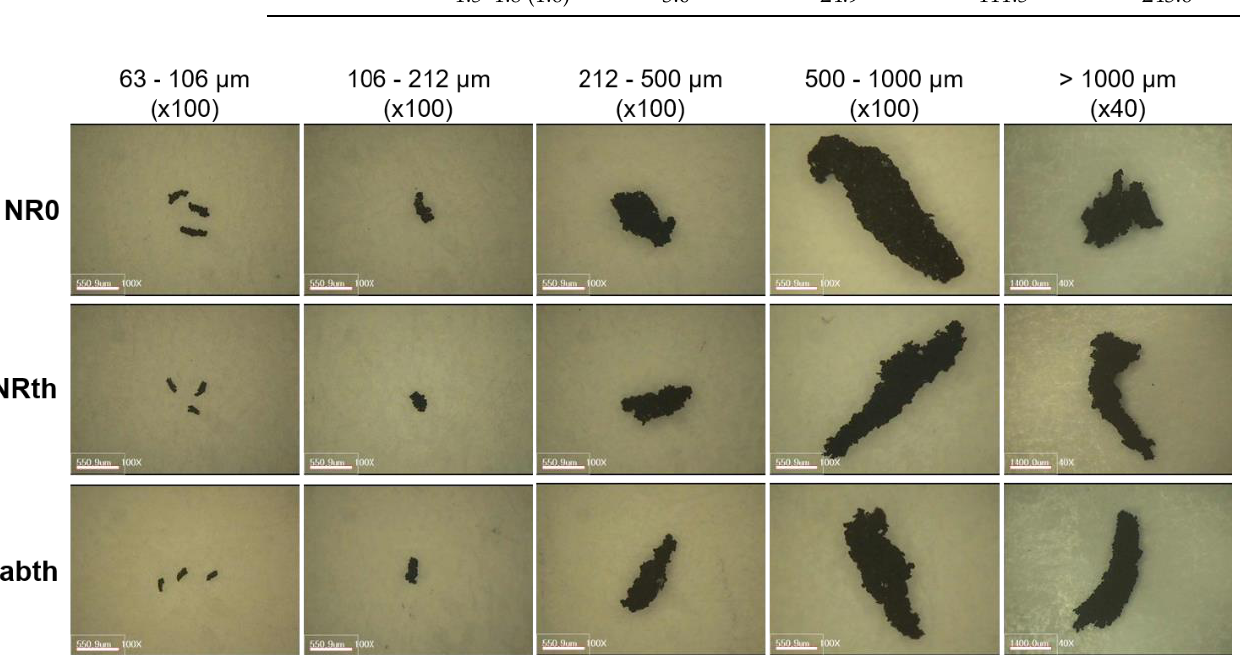
Figure 1. Magnified images of the wear particles. The magnification of wear particles larger than 1000 μ m was 40 (the scale bar: 1000 m), and the others were 100 (the scale bar: 550 m).